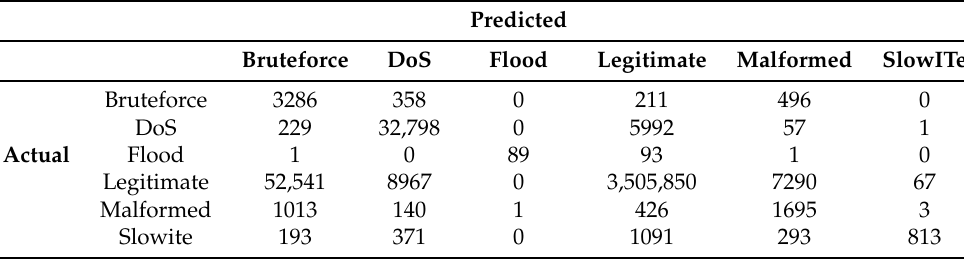
Table 9. Confusion matrix decision